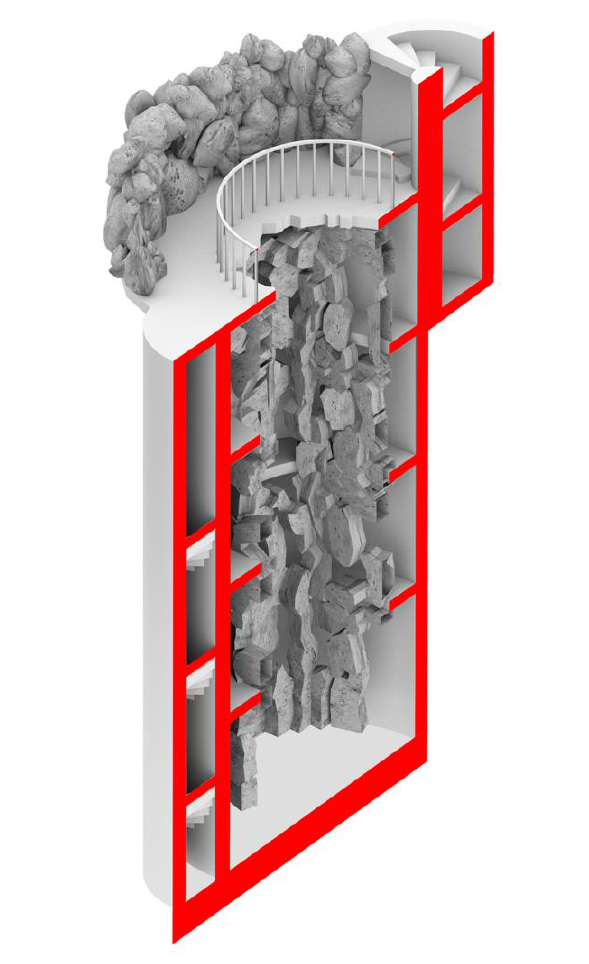
Figure 10 . The Quinta da Regaleira in Sintra, the Poço Imperfeito , model cross section.